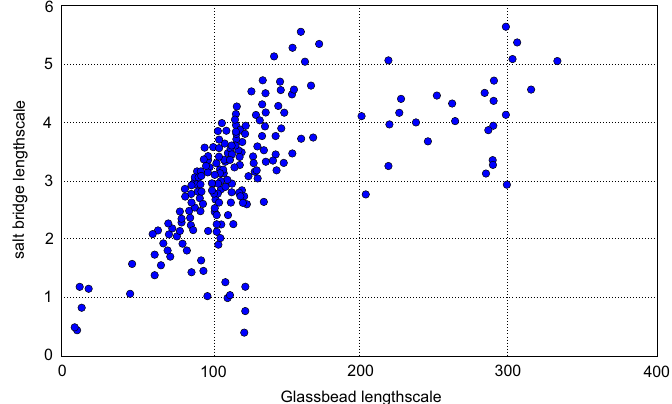
Figure 5. Solid NaCl bridge volumes evaluated from SEM analysis are plotted against total available surface of the two particles connected through the solid bridge. Maximum salt bridge volumes show exponential dependence on available particle surface area.